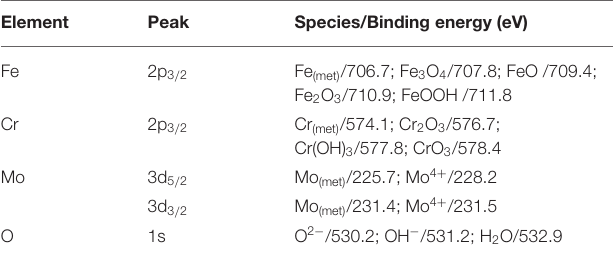
TABLE 2 | The binding energies of the primary compounds of the PH13-8Mo stainless steel passive film and corrosion products obtained from XPS spectra